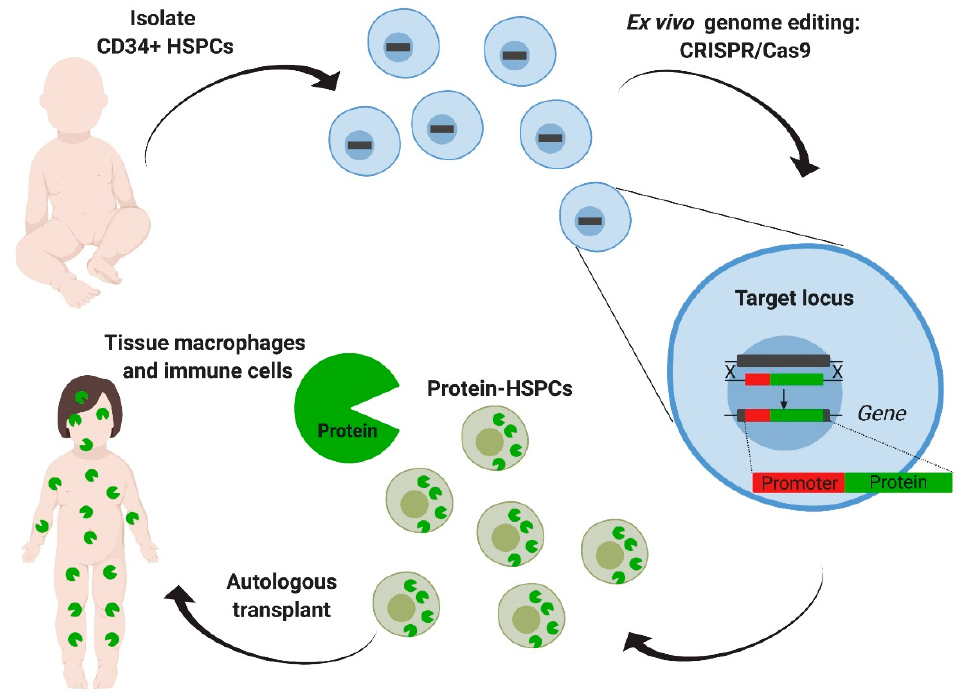
Figure 4. Ex vivo genome editing of hematopoietic stem cells targeting a safe harbor locus. Hematopoietic stem and progenitors cells (HSPCs) derived from the patient are targeted with CRISPR / Cas9 aiming the addition of the deficient enzyme’s coding sequence, driven by an exogenous constitutive promoter in the CCR5 safe harbor locus. After transplantation, modified HSPCs will eventually engraft, reconstitute the hematopoietic system, and generate tissue macrophages and other immune cells that can produce and deliver the enzyme. This strategy eliminates the need for donor matching and decreases the risk of graft-versus-host disease. Furthermore, a safe harbor extends its applicability to other lysosomal